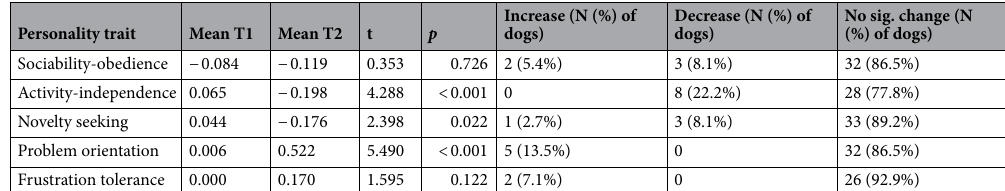
Table 4. Changes in five personality traits between the two test sessions (analysed with paired t-test), and distribution of the individual dogs based on their Reliable Change Index (RCI) scores. The distribution expected by chance would be 2.5% of the dogs to significantly increase, 2.5% to decrease, and 95% to show no significant change from Test 1 to Test 2 2